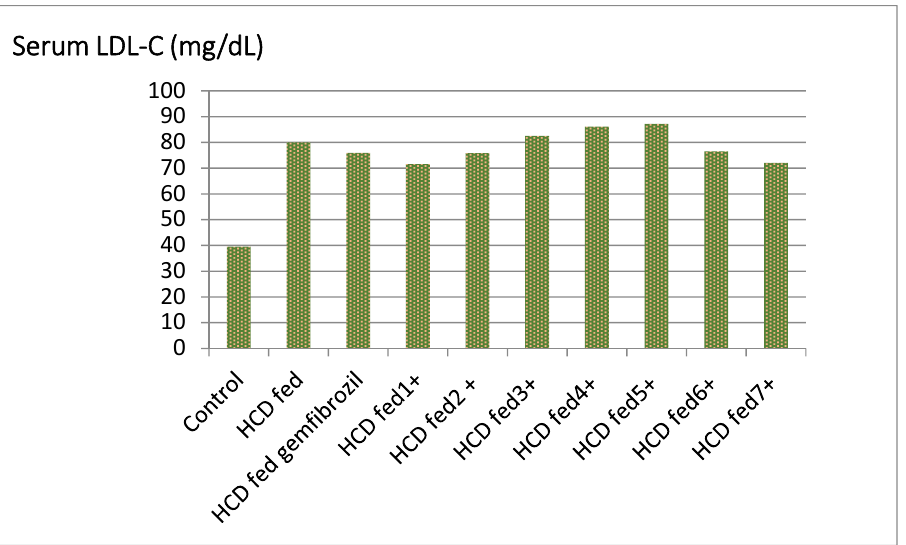
Figure 3. Effect of the tested compounds and gemfibrozil on serum HDL-C of hyperlipidemic rats.